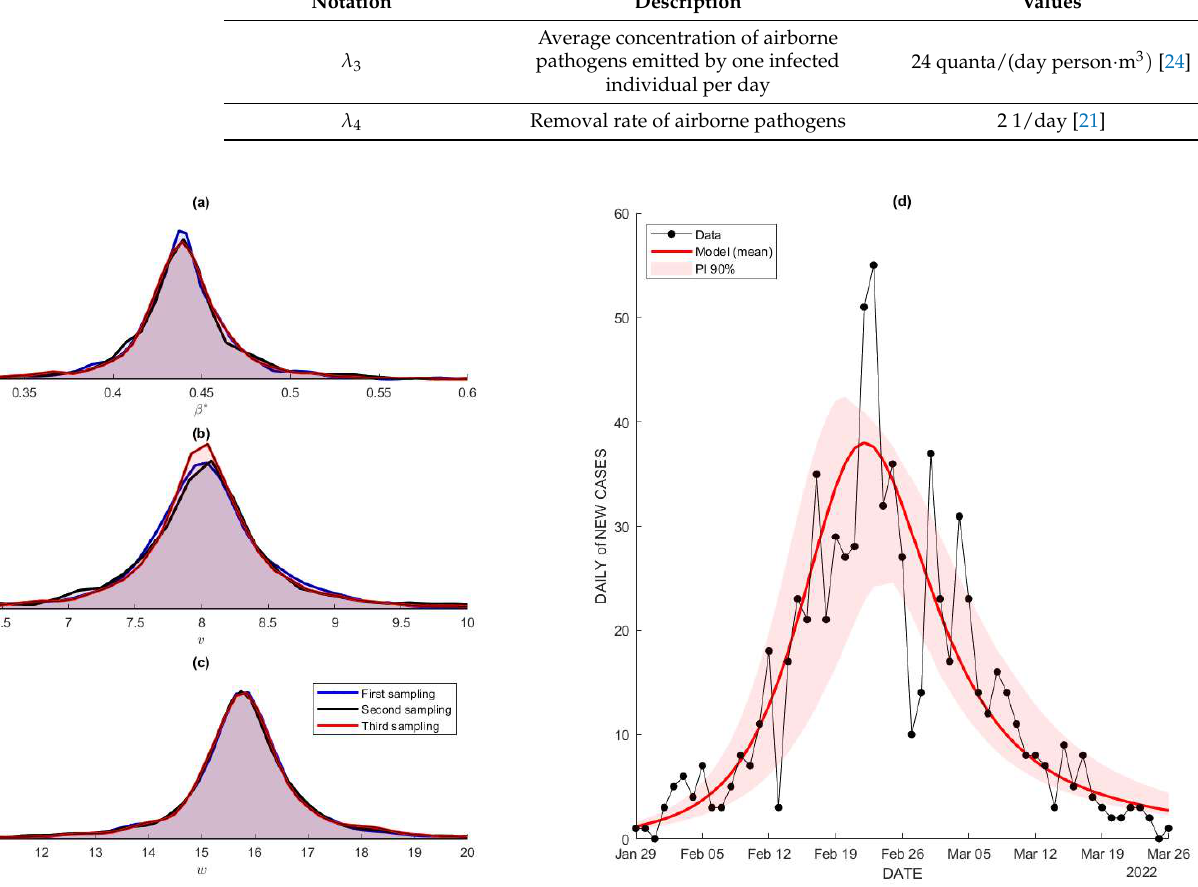
Figure 6. ( a – c ) Posterior distribution for 𝛽 ∗ , 𝑣 , and 𝑤 , estimated using MCMC method with prior of normal distributions: 𝒩(𝜇, 𝜎) , with 𝜇 being the estimated single point and 𝜎 being a higher value to acquire the possibility of achieving the global minima. We generated three independent samples to portray the posterior density to ensure its consistency. ( d ) The comparison between the data (daily new cases) and the model with its 90% prediction interval.